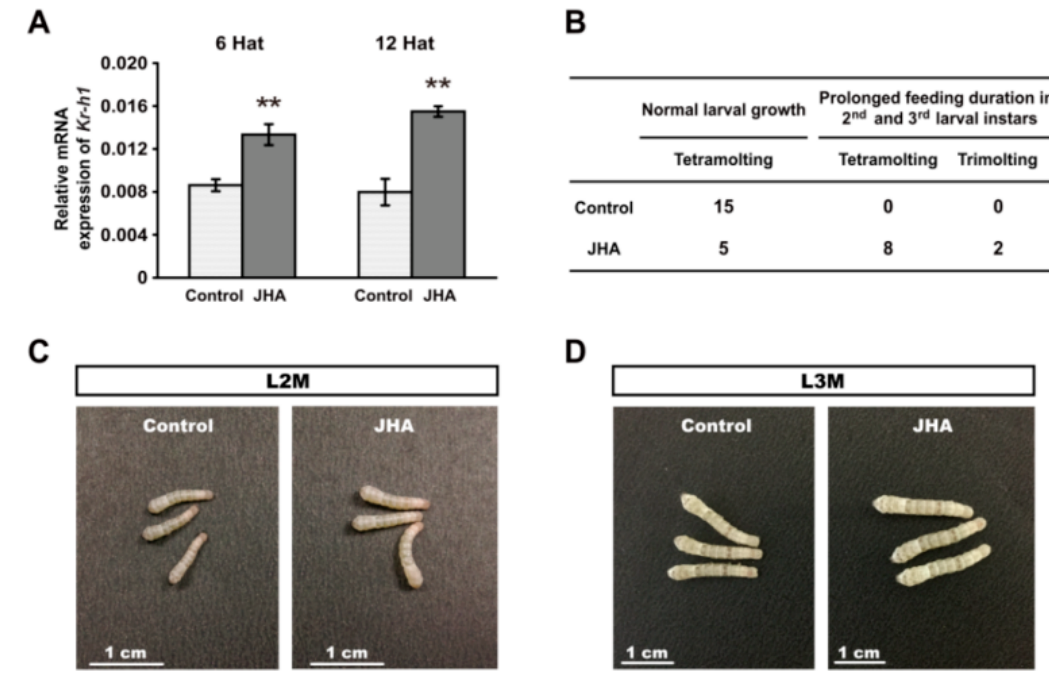
Figure 3. Cont. Figure 3.